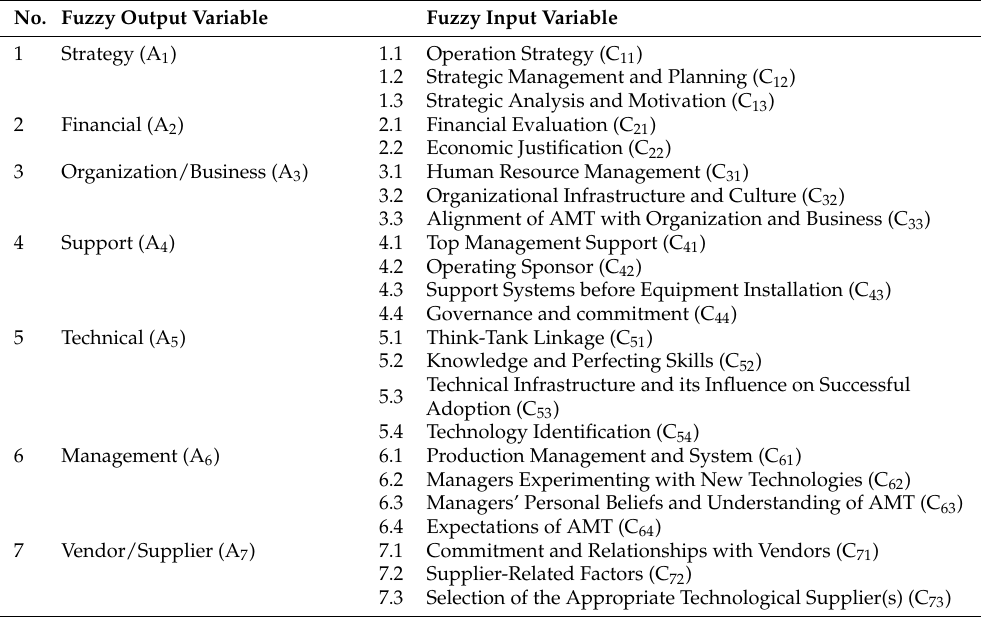
Table 6. List of aspects and corresponding